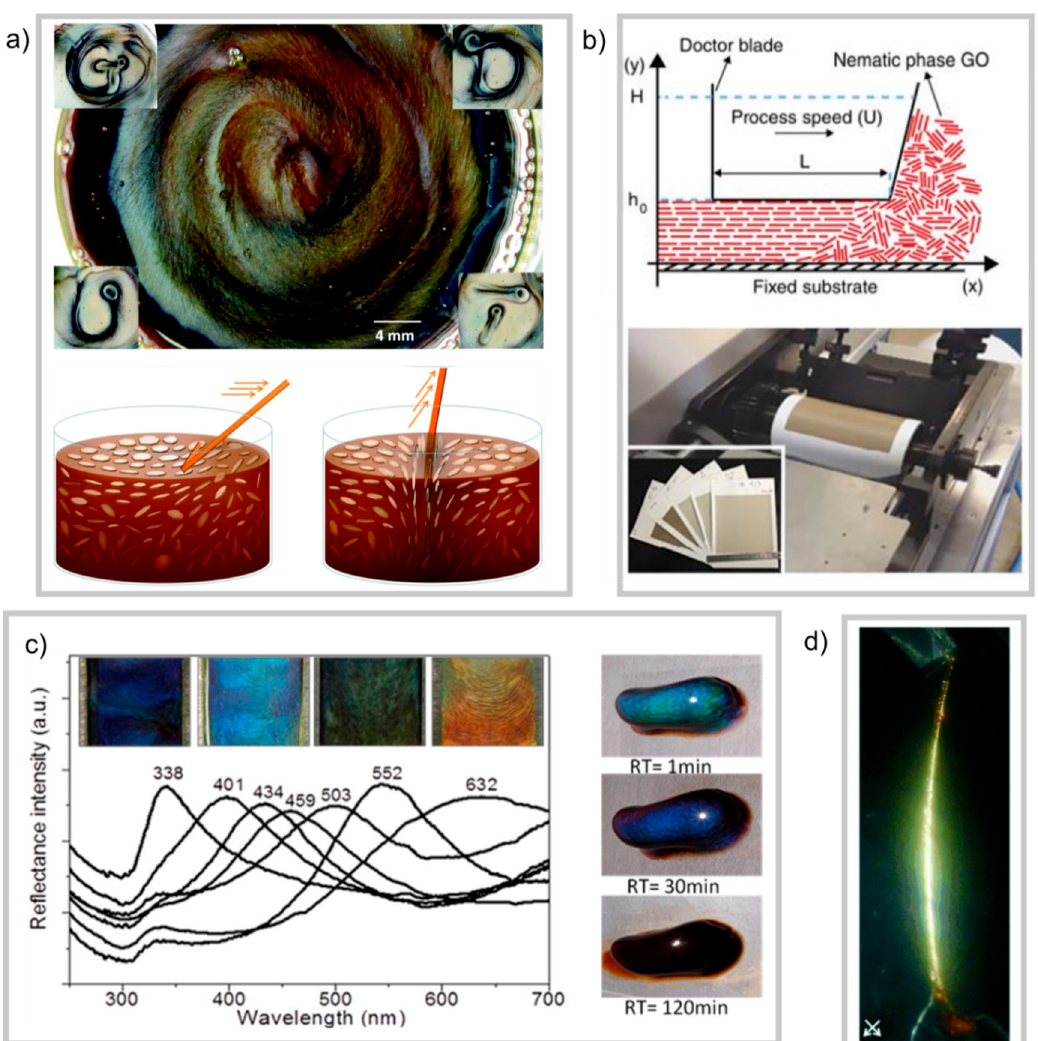
Figure 17. ( a ) A rewritable reflective display based on a graphene oxide nematic liquid